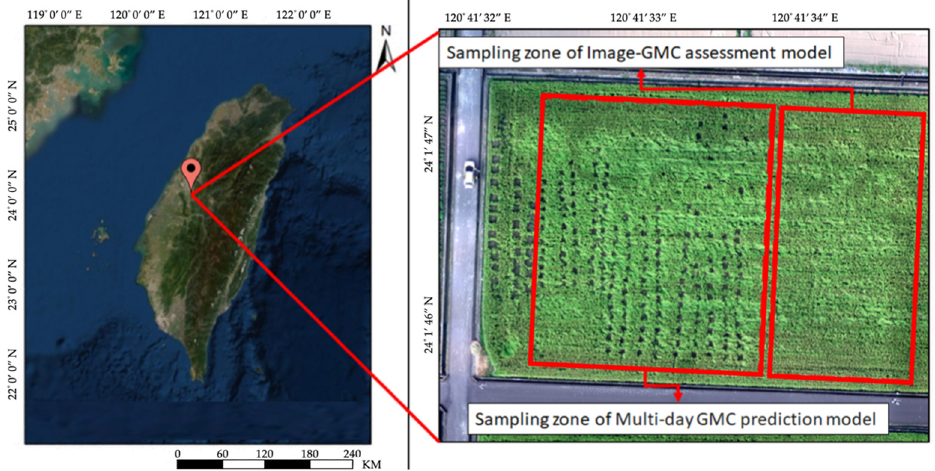
Figure 3. The study site at the Taiwan Agricultural Research Institute.